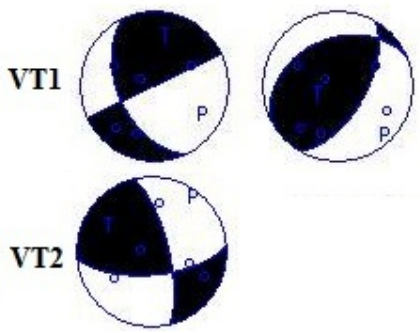
Figure 9. Focal mechanisms calculated for VT1 (up) and VT2 (bot- tom). P and T axes are indicated.